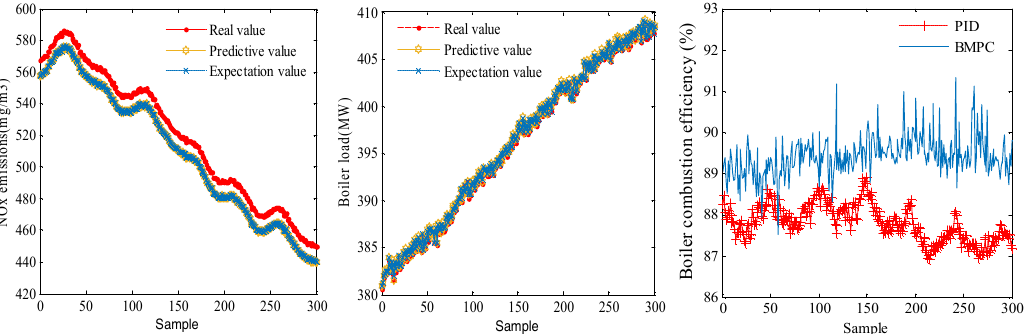
Figure 9. Theresults obtained with the model predictive control under operating condition 1.